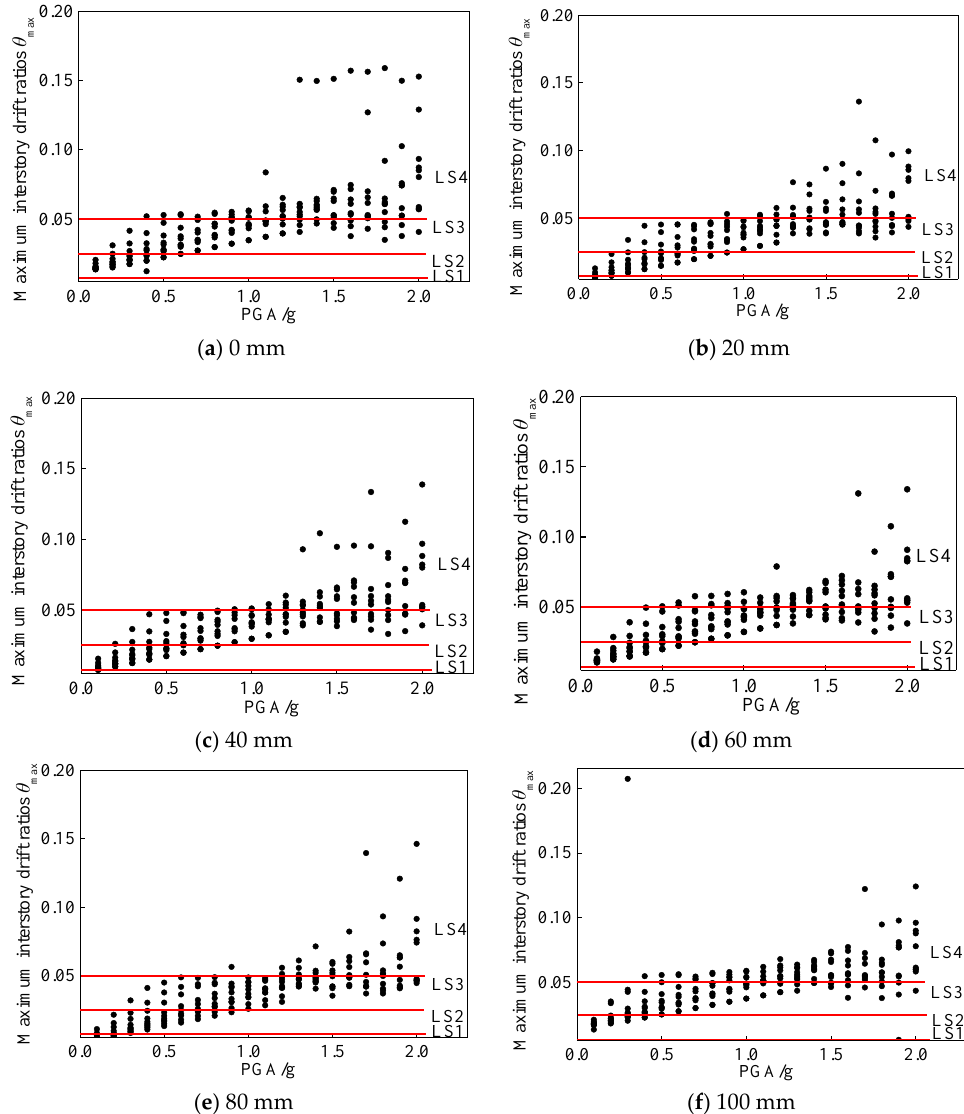
Figure 3. Relationship between structural demand and peak ground acceleration (PGA) of Zone I.